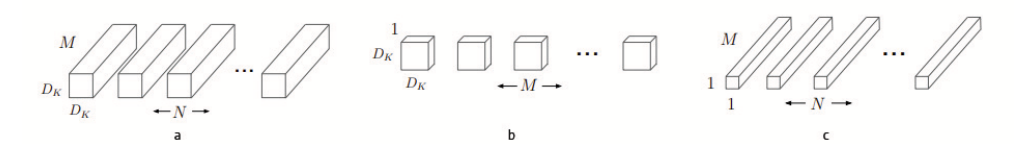
Figure 9. Standard and MobileNet [38] filters in CNN: ( a ) standard CNN’s filters, ( b ) depthwise convolution, ( c ) separable depthwise